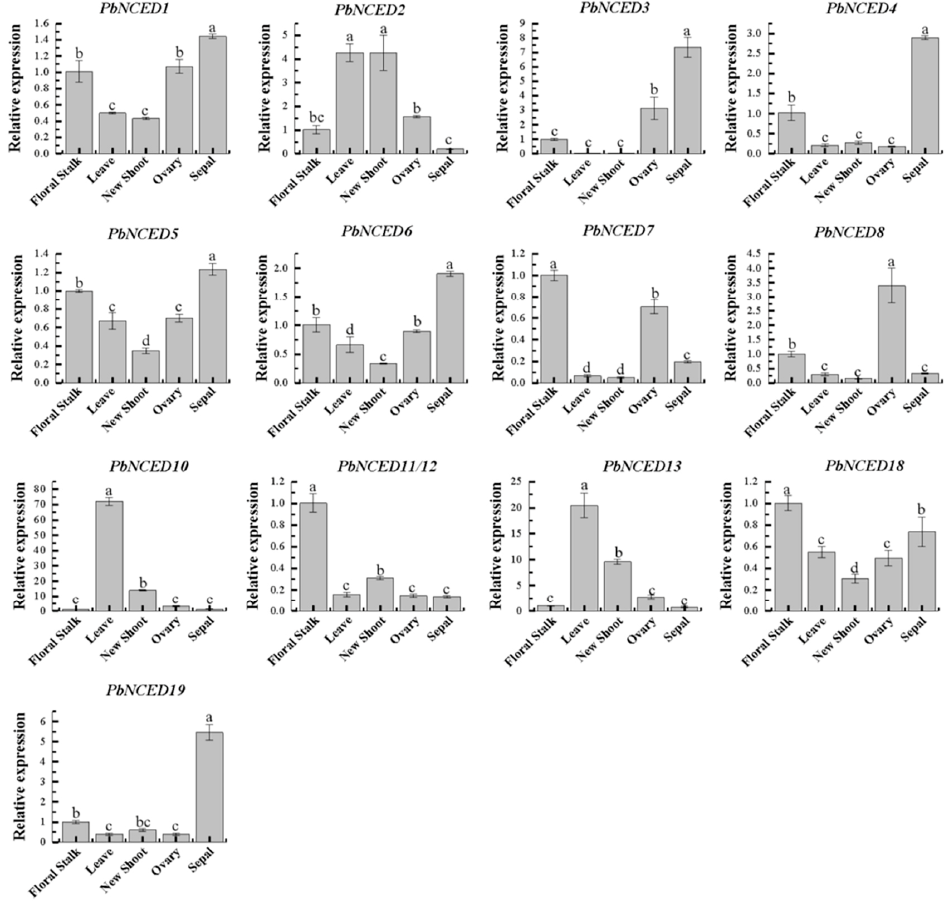
Figure 7. Relative expression level of PbNCED genes in di ff erent tissues. Di ff erent le tt ers indicated signi fi cant di ff erences between groups ( p < 0.05).